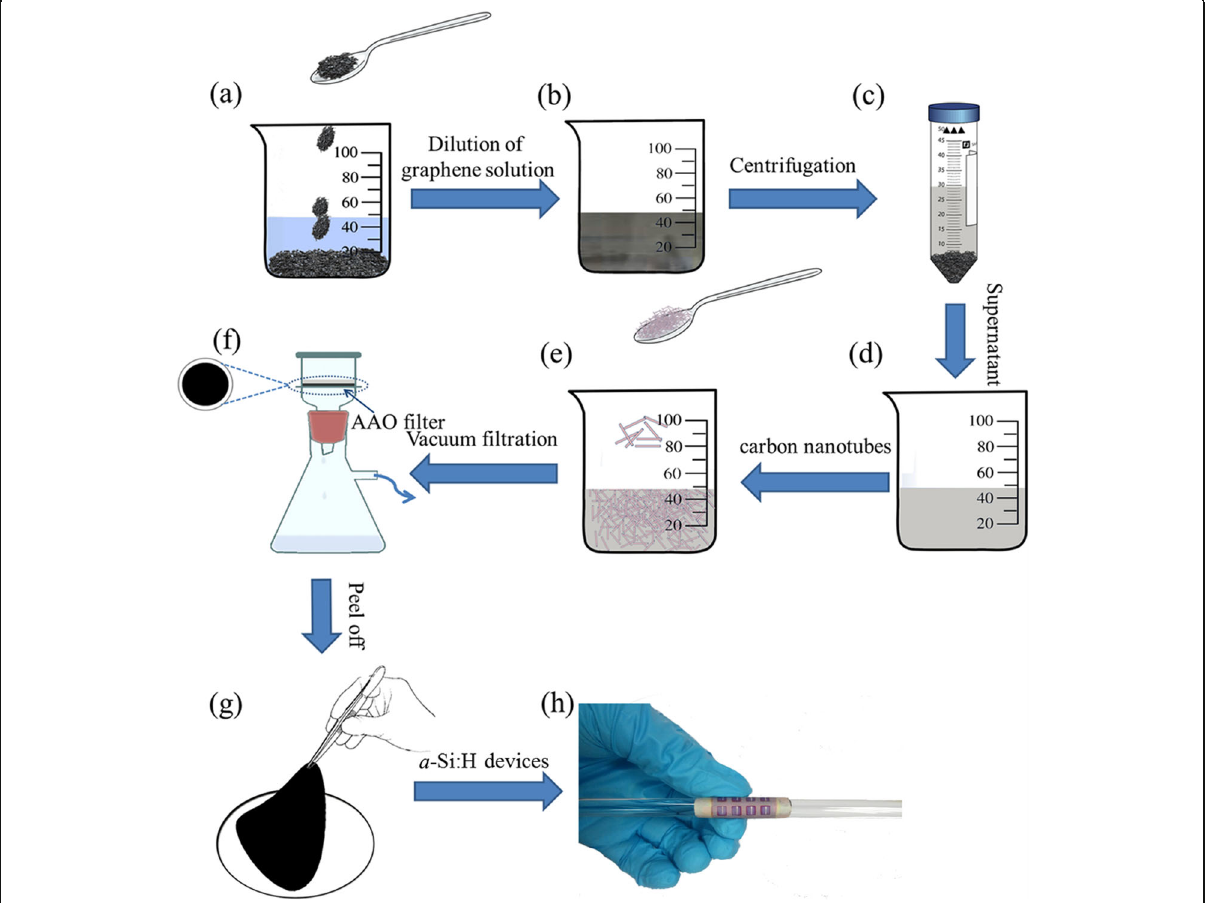
Fig. 2 Fabrication procedures of the solar cell based on graphene paper. ( a ) Addition of reduced graphene oxide sheet in the aqueous solution of cetyltrimethylammonium bromide. ( b ) Dispersion of the mixture solution. ( c ) Centrifugation of the graphene solution. ( d ) Collection of the supernatant with well dispersed graphene flakes. ( e ) Addition of carbon nanotubes to the supernatant. ( f ) Vaccum filtration of the solutions over the through-hole anodic aluminum oxide membrane to obtain graphene paper on the anodic aluminum oxide filter. ( g ) Separation of graphene paper from the anodic aluminum oxide filter after drying. ( h ) a-Si:H solar cells fabricated on the graphene paper substrate demonstrate